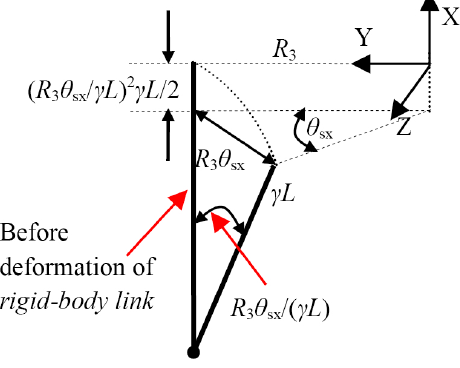
Figure 5. Kinematic schematic diagram of twisting rotation about the x axis of the spatial three-beam